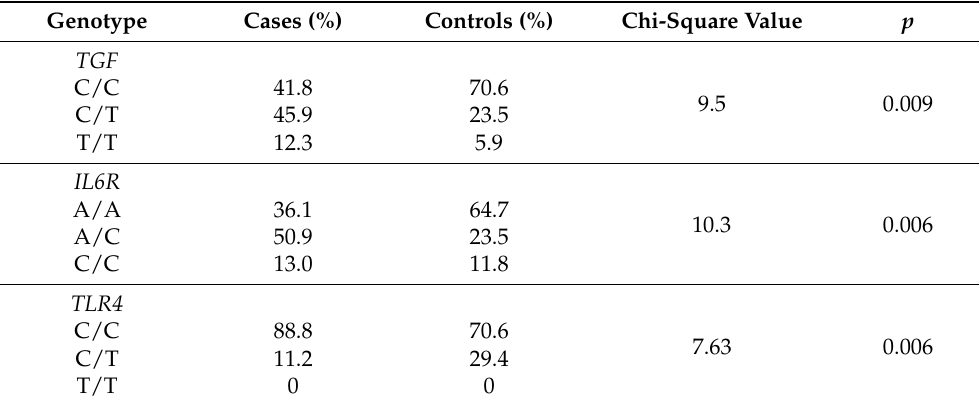
Table 2. Percentage TGF (rs1800469), IL6R (rs8192284) and TLR4 (rs4986791) genotype